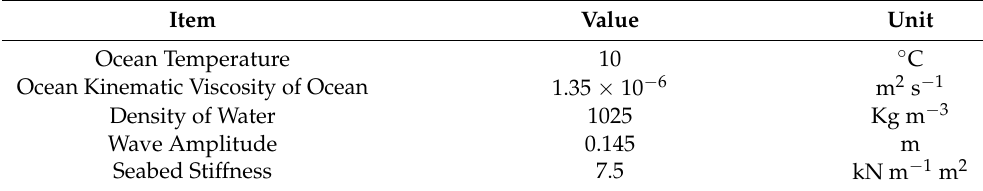
Table 7. Parameters for the ocean and seabed.